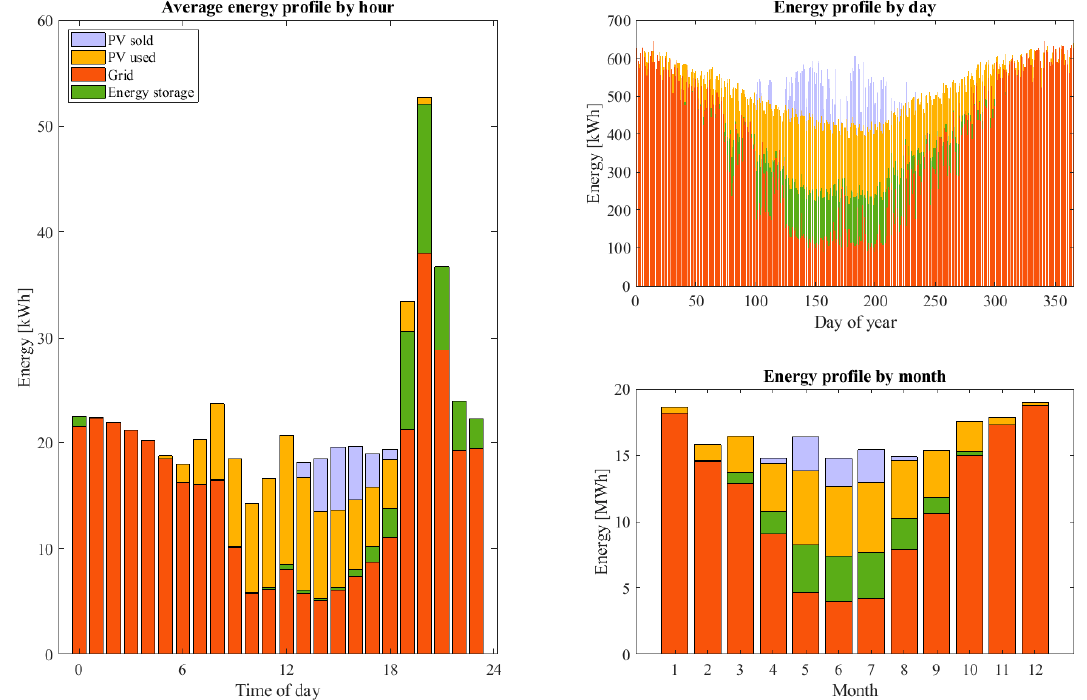
Figure 12. Average energy profiles by hour, day, and month in scenario 1.b.